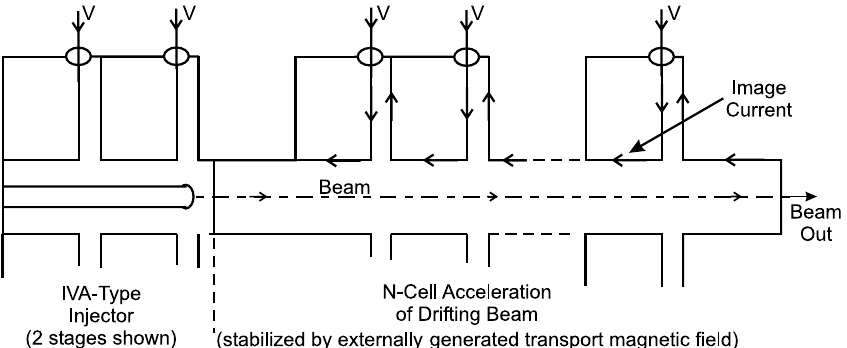
FIG. 2. Schematic of linear induction